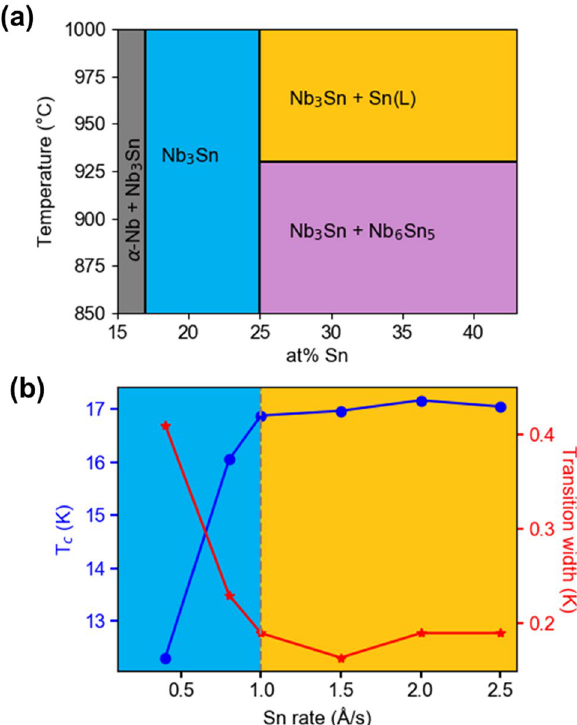
Figure 2. Connecting the Nb-Sn phase diagram to electrical properties and process window. ( a ) Relevant adsorption-controlled growth regime (orange) of Nb-Sn phase diagram. Nb 3 Sn spans 17–25% Sn, and the desired Nb 3 Sn + liquid Sn field lies above 930 °C and 25% Sn. ( b ) T c , ΔT c , vs the Sn flux of 60 nm thick Nb 3 Sn single layer thin films on